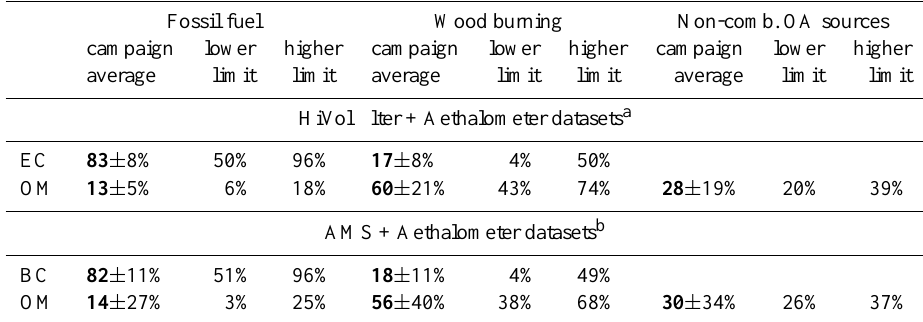
Table 5. Mean contributions ( ± one standard deviation) of fossil fuel combustion, wood burning and non-combustion OA sources to carbonaceous aerosols obtained with the Aethalometer model and using the two different { EC/BC+OM } datasets (see Sect. 6.2). Lower and higher limits correspond to mean contributions obtained when ranging α ff from 0.9 to 1.1, α wb from 1.5 to 3.0, and C 1 from 2.0 × 10 5 to 3.2 × 10 5 (see Sect. 6.1) . Fossil fuel Wood burning Non-comb. OA sources campaign lower higher campaign lower higher campaign lower